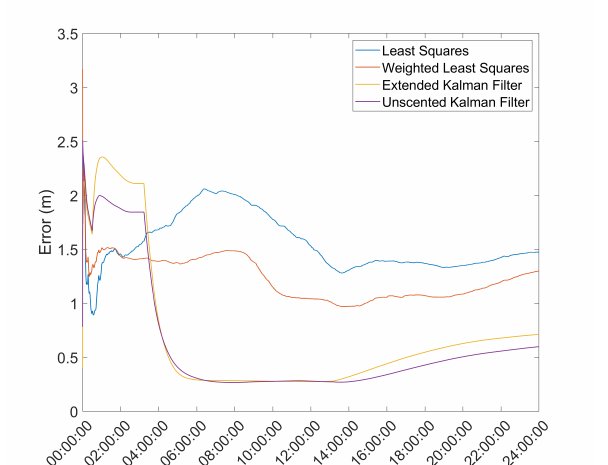
Figure 8. Effect of a 2 σ threshold on the mean error over time for the reference station antenna with no Hatch Filter.